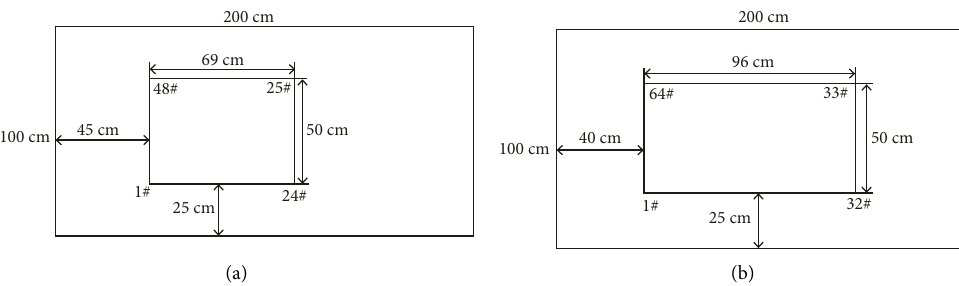
Figure 3: The physical model of electrical test system layout. (a) 15 cm above the coal seam and (b) 40cm above the coal